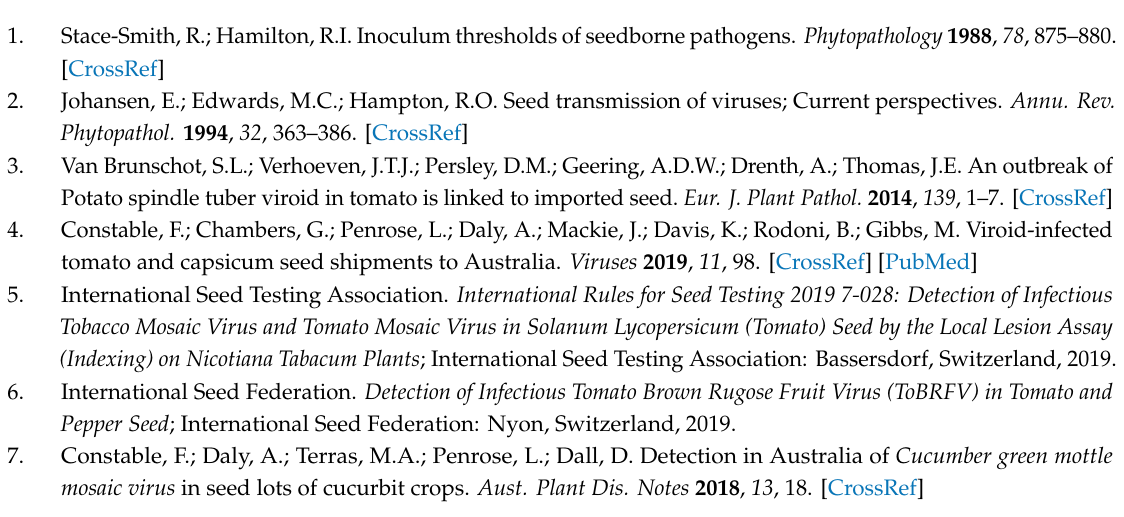
Table S1: Ranked prevalence estimates for pospiviroids in contaminated tomato and capsicum seed